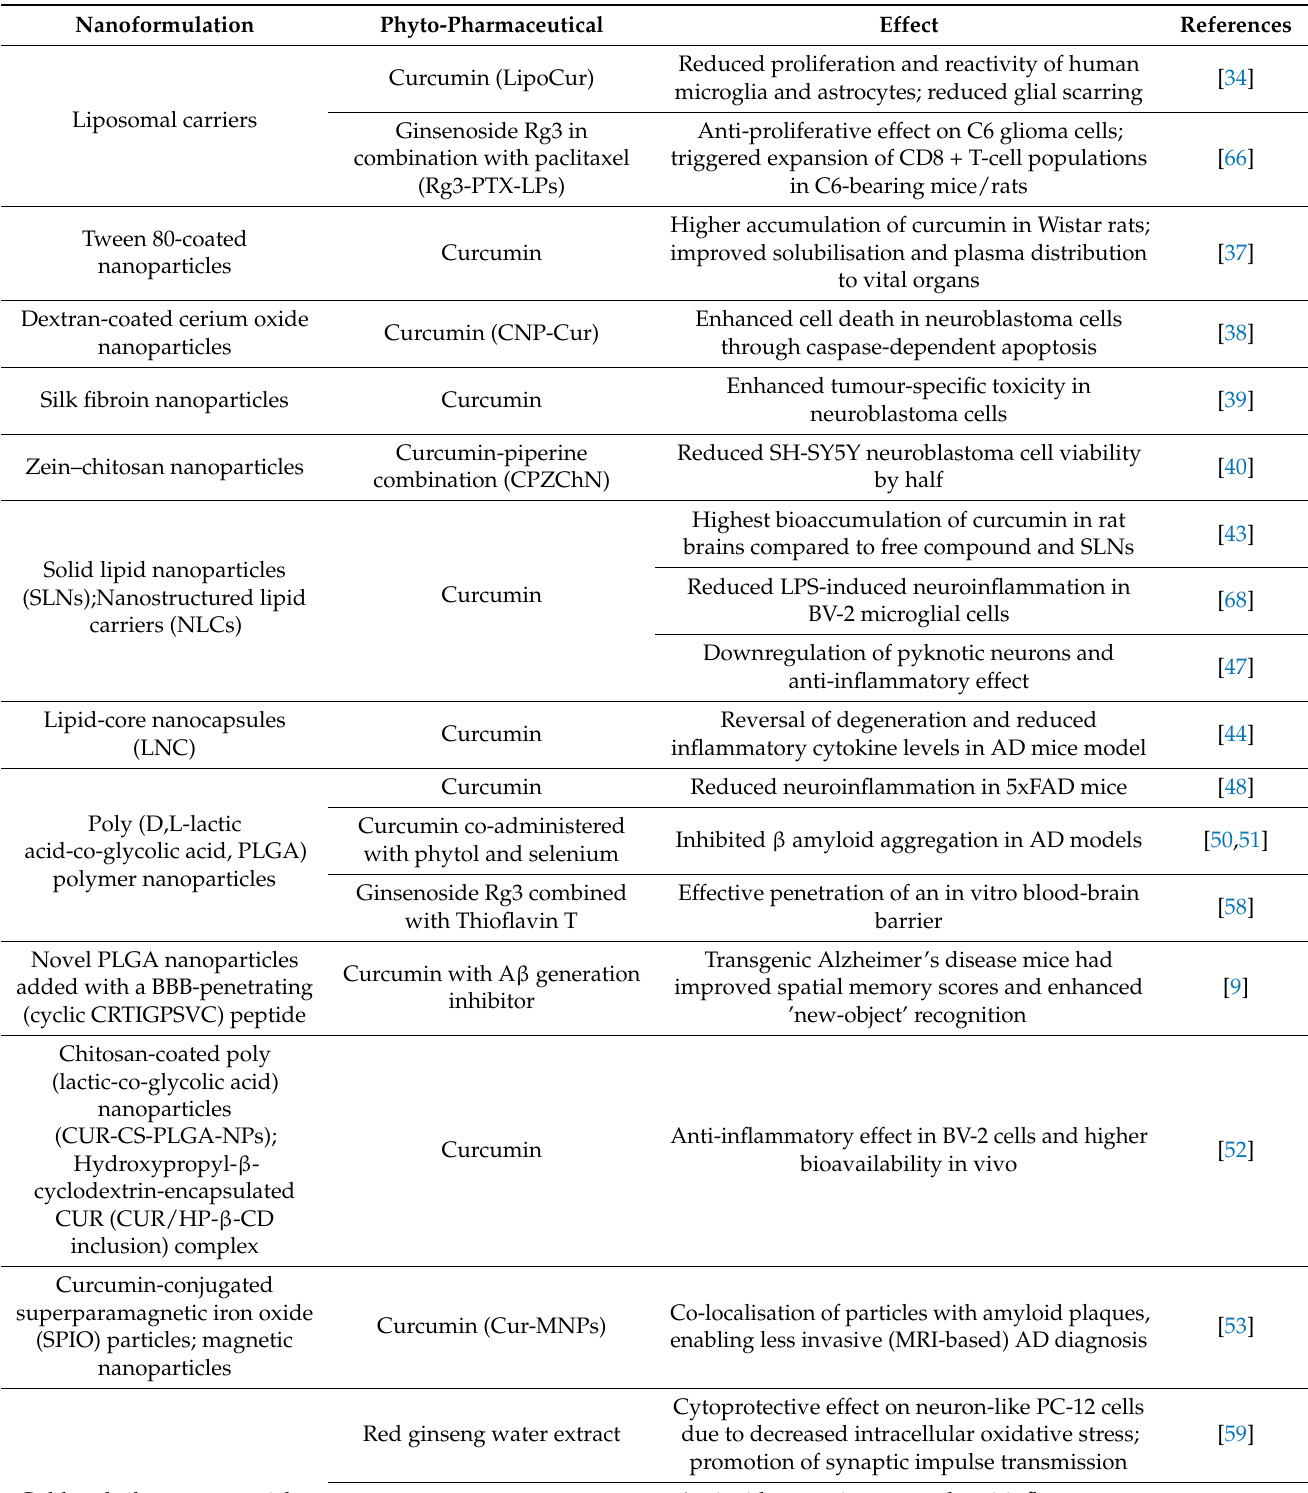
Table 1. Nano-formulations of active compounds or extracts from curcumin and ginseng for neuro- logical